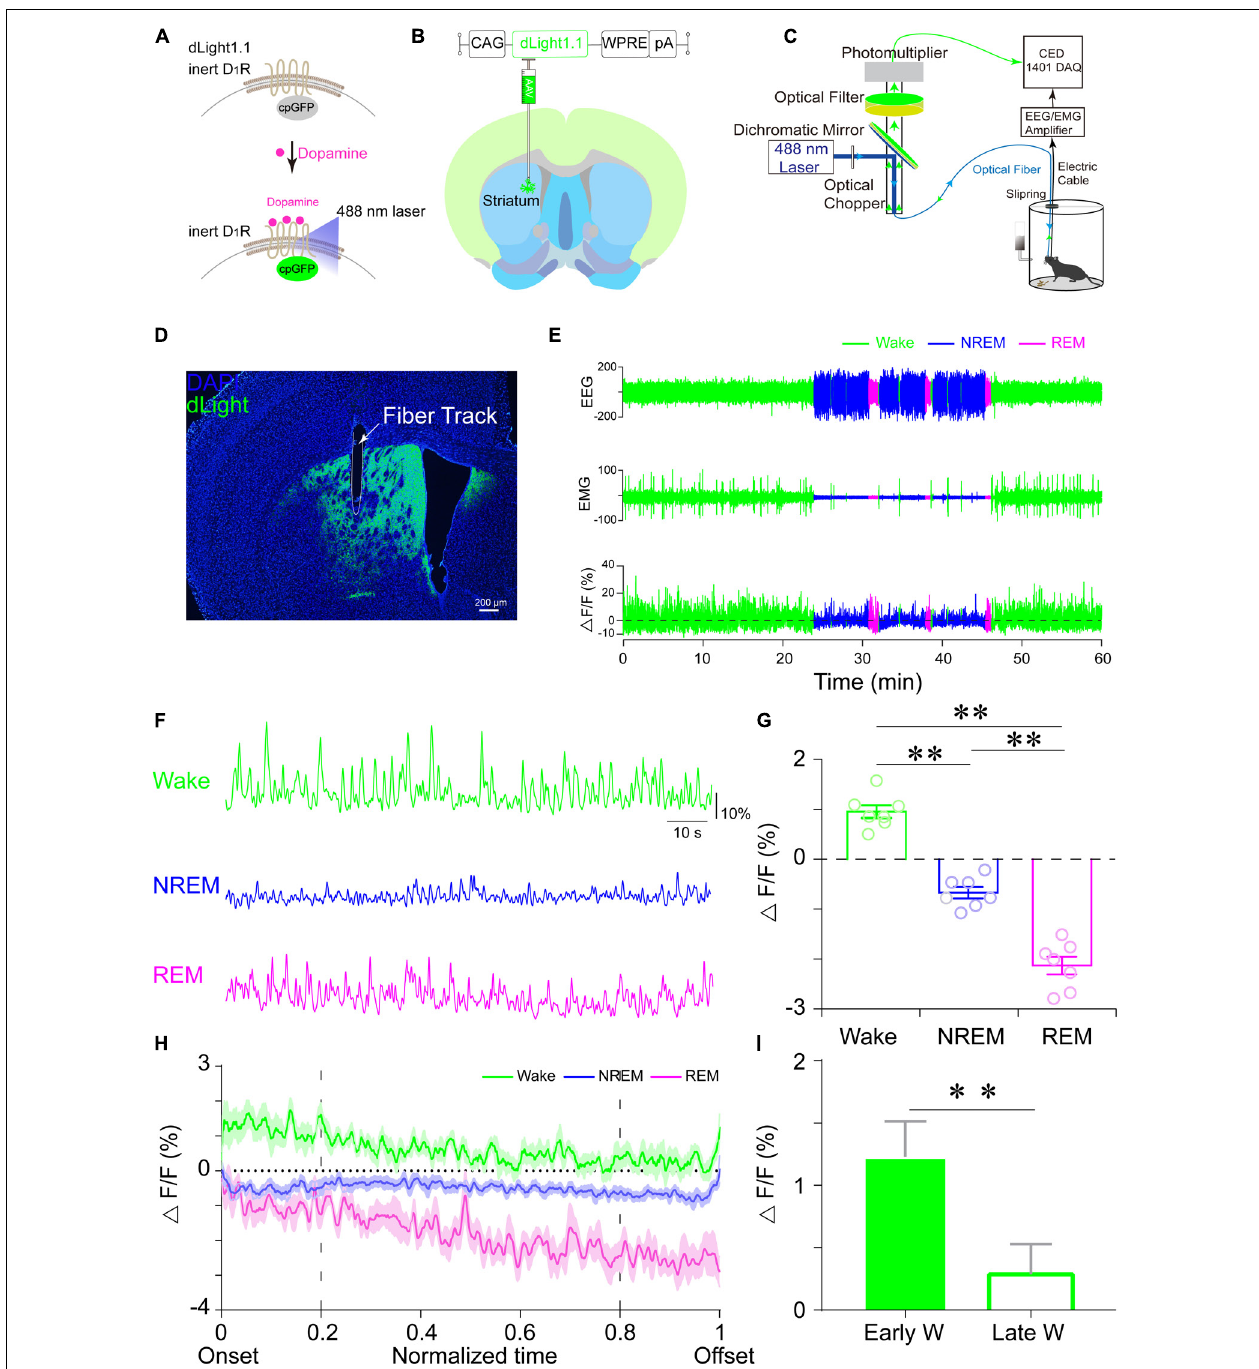
FIGURE 1 | Striatal dLight1.1 signals at distinct spontaneous sleep–wake states. (A) Schematic diagram of dLight1.1 with the dopamine D 1 receptor and circularly permuted GFP (cpGFP) module (upper panel) and the working principle of dLight1.1. (B) Schematic showing the injection of AAV-CAG-dLight1.1 into the dorsal striatum. (C) Schematic showing the setup for fiber photometry used to assess dLight1.1 fluorescence with simultaneous polysomnographic recordings. (D) Expression of dLight1.1 in the dorsal striatum. The scale bar is 200 µ m. (E,F) Representative EEG, EMG, and fluorescent photometry signal traces of striatal dLight1.1. during distinct sleep–wake states (green, wake; blue, NREM sleep; magenta, REM sleep). (G) Quantification of the average striatal dLight1.1 signal at distinct sleep–wake states. One-way ANOVA: F 2 , 18 = 116.1, P < 0.0001; Tukey’s post hoc test: wake vs. NREM sleep ∗∗ P < 0.0001, wake vs. REM sleep ∗∗ P < 0.0001, NREM vs. REM sleep ∗∗ P < 0.0001; n = 7 mice. (H) Temporal dynamics of the striatal dLight1.1 signal during long-term wake (green), NREM sleep (blue), and REM sleep (magenta) episodes within normalized time. (I) Striatal dLight1.1 signal at the early wake period (first 20% of wake period) and the late wake period (last 20% of wake period) ( t 6 = 5.058, ∗∗ P = 0.0023, n = 7 mice).